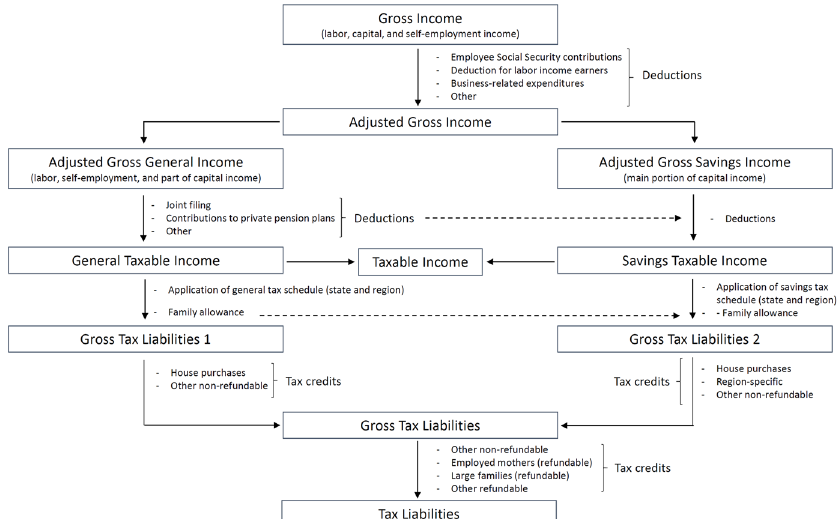
Fig. 1 Structure of the Spanish personal income tax (2015)